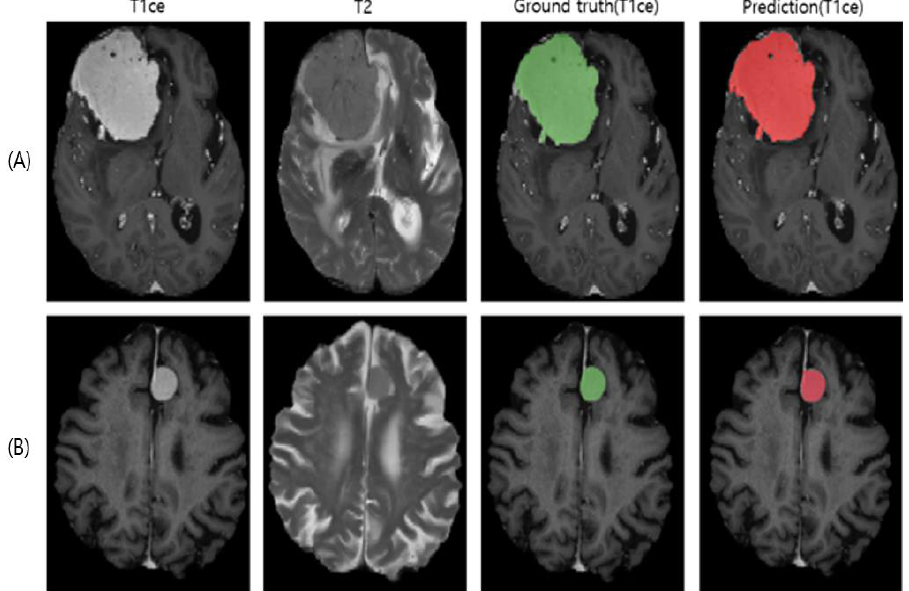
Figure 1. Representative meningioma segmentation models learned using transfer learning, normal brain MRIs, and balanced Dice loss (BDL). Two patients ( A , B ) were from the test set. Note that the ground truth was generated based on T1ce.